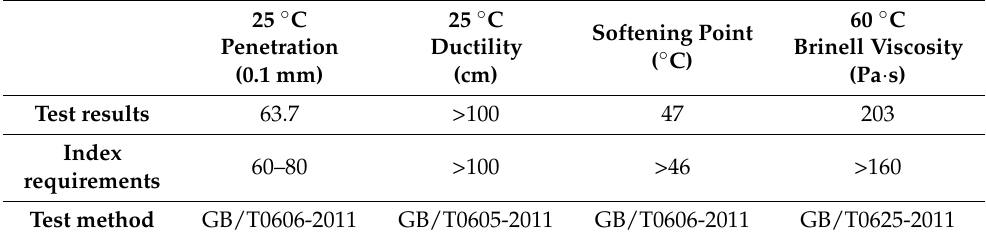
Table 1. Conventional indexes of base